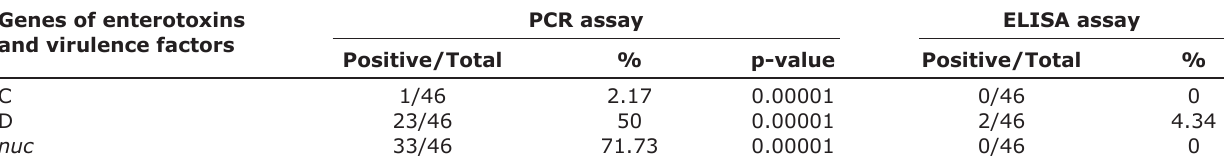
Table-3: Frequency distribution of some genes of enterotoxins and virulence factors of S. aureus occurred in bovine subclinical mastitic milk. Genes of enterotoxins and virulence